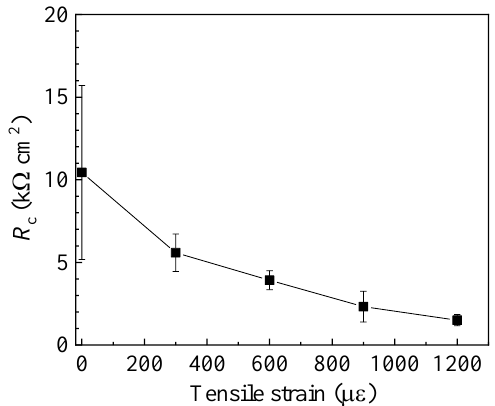
Figure 9. Effect of the tensile strain level on the enamel coating resistance.